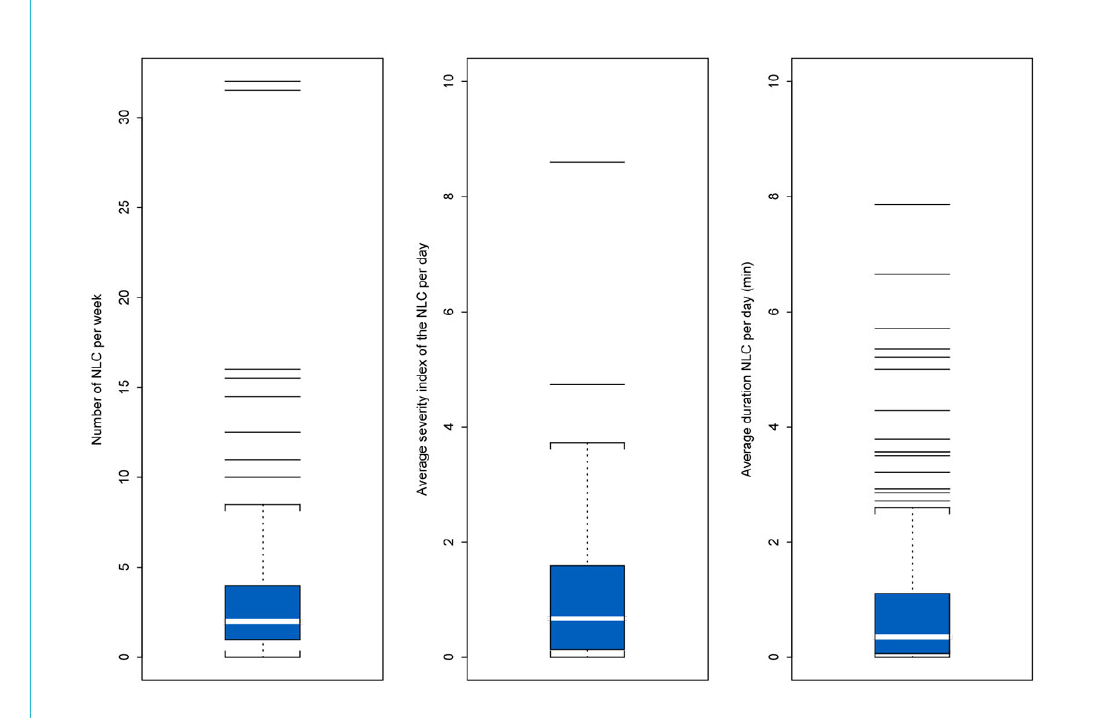
Figure 1: Number of nocturnal leg cramps (NLC) per week, average severity index per day, and average duration in minutes per day per pa- tient (n =